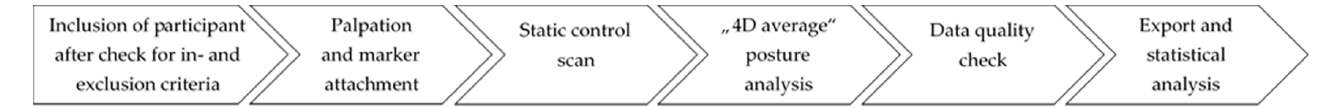
Figure 1. Schematic flow chart of the experimental process.